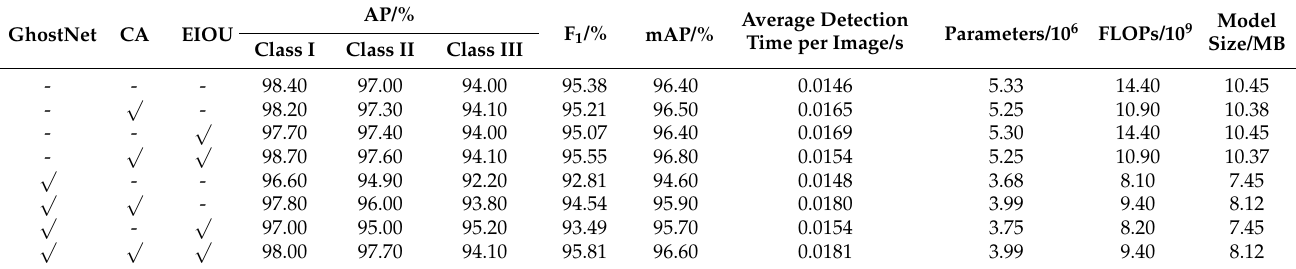
Table 3. Ablation